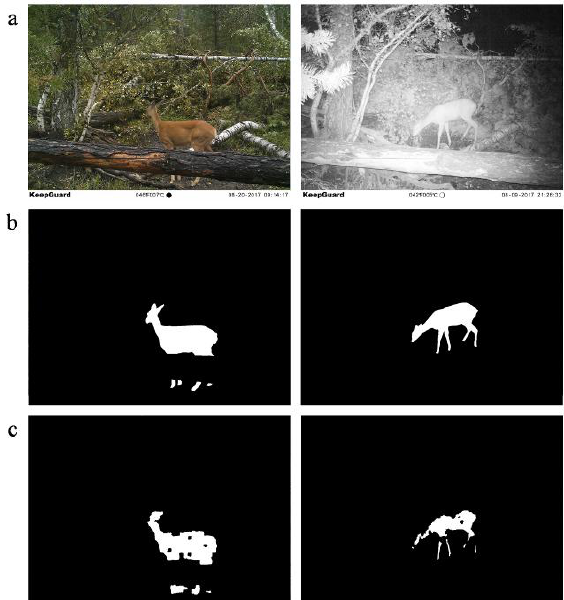
Figure 8. Example of animal detection using proposed method: a) original images, b) ground truth, c) motion